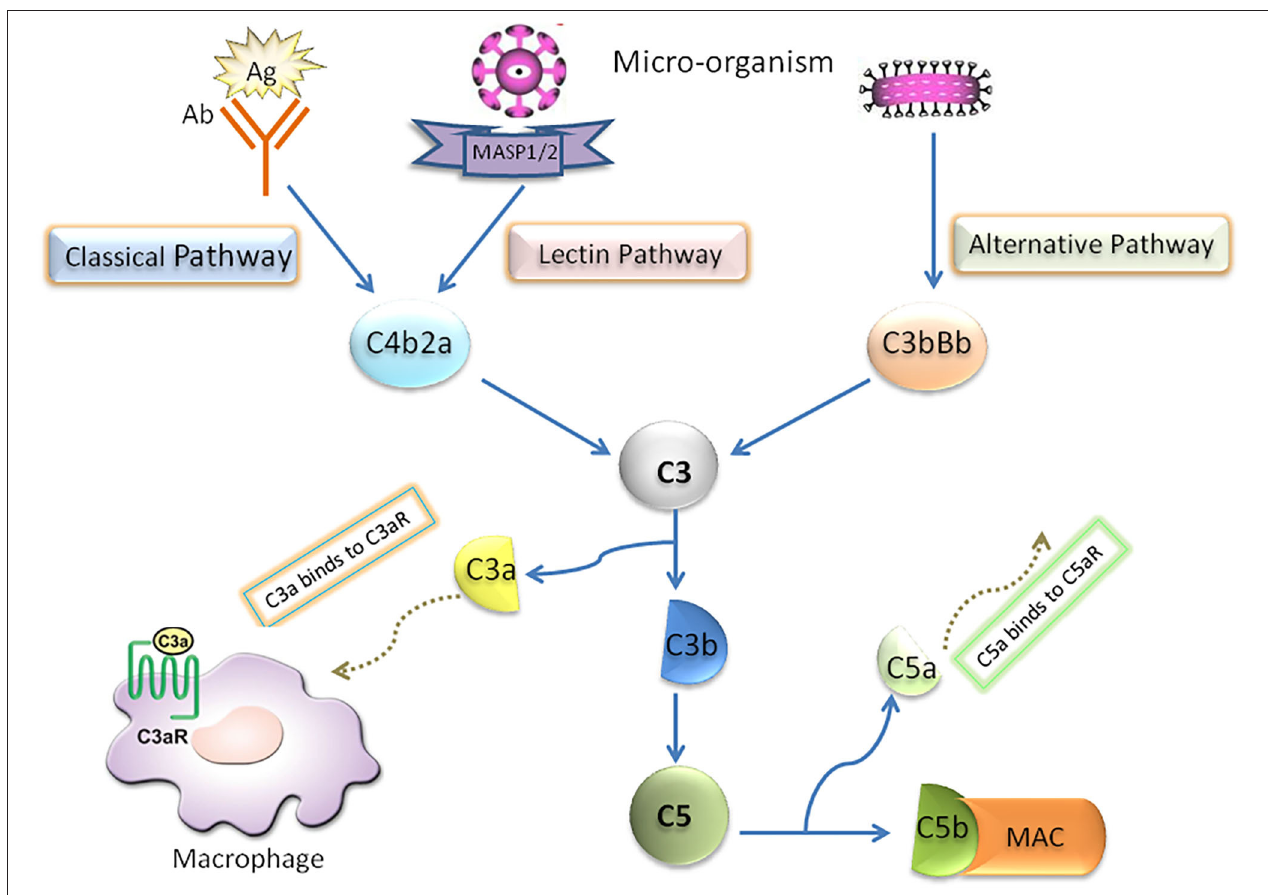
FIGURE 1 | Schematic diagram of complement system